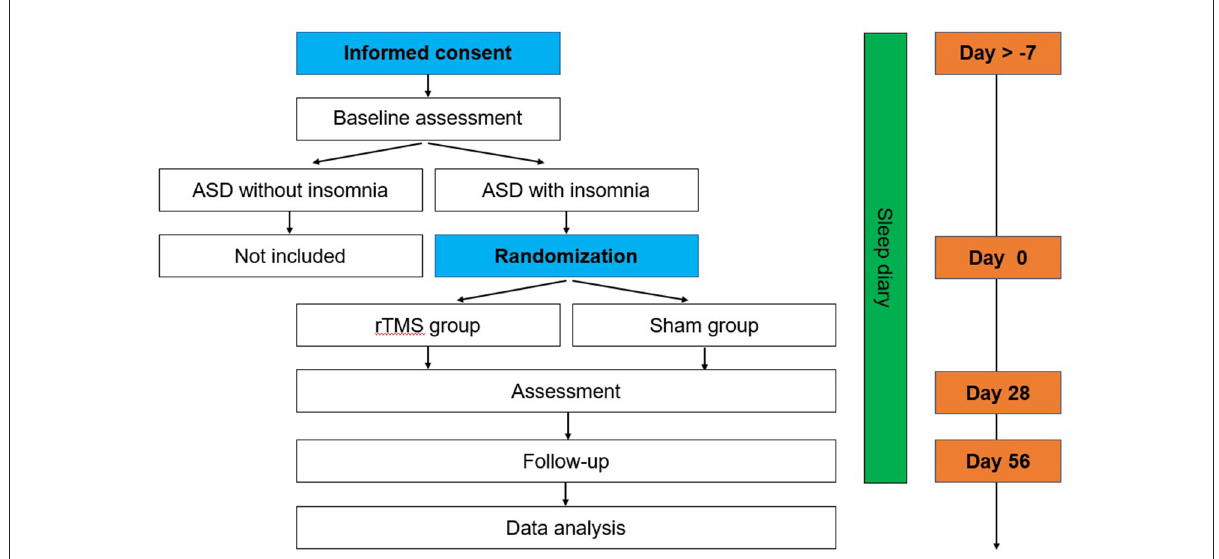
FIGURE1 Time schedule of screening, interventions, assessments and visits of